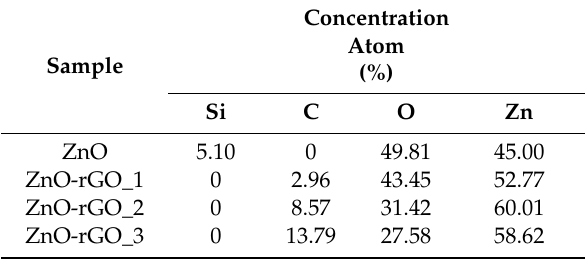
Table 2. Energy dispersive spectroscopy (EDS) analysis of ZnO and ZnO-rGO thin films.